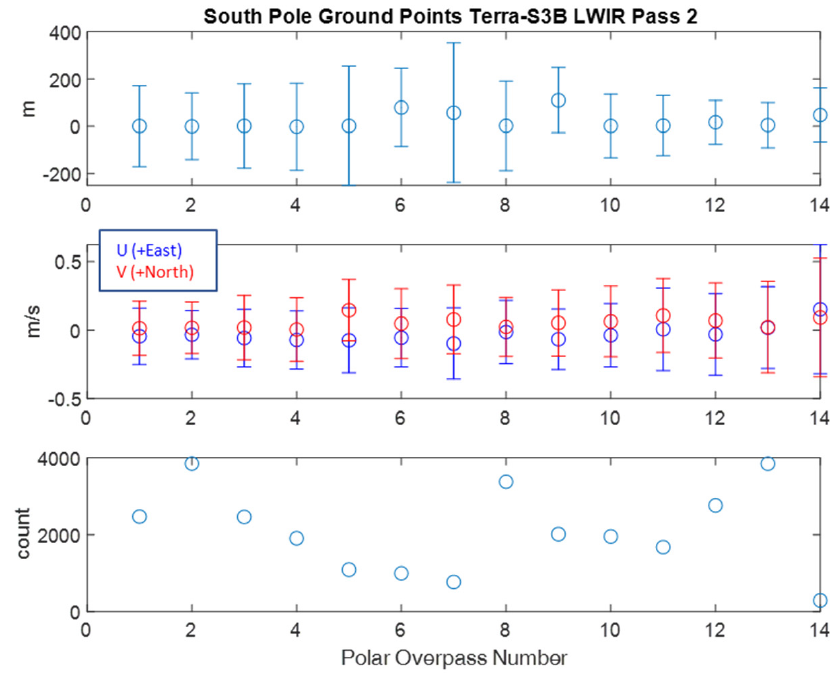
Figure 9. Ground-point retrieval statistics, after the second processing pass shows unbiased results for the same overpasses as shown in Figure 7. There is a small trend towards increasing retrieved wind standard error (error bars) from left to right, which is the direction in which the acquisition time | ∆ t | between SLSTR and MODIS decreases from 29 min on the left to 1 min on the right in steps of approximately 2 min.